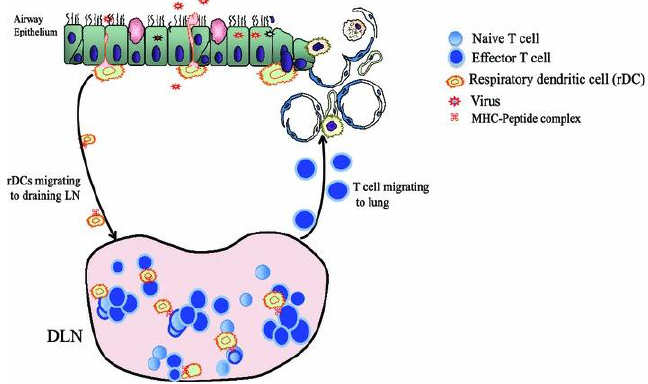
Figure 1. T cell response with respiratory virus infection